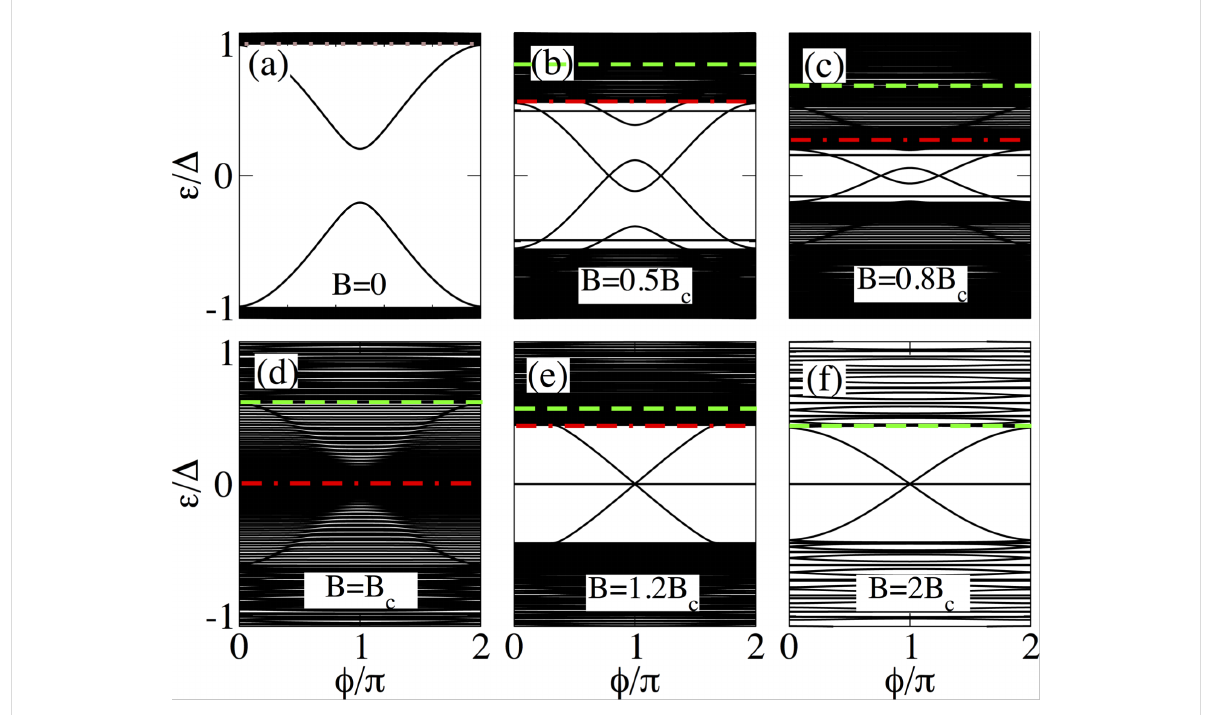
Figure 6: Same as in Figure 4 for a short junction with L N = 20 nm and L S = 10000 nm. Note that in this case, the emergent outer MBSs are disper- sionless with , while the inner ones touch zero at = π acquiring Majorana character.